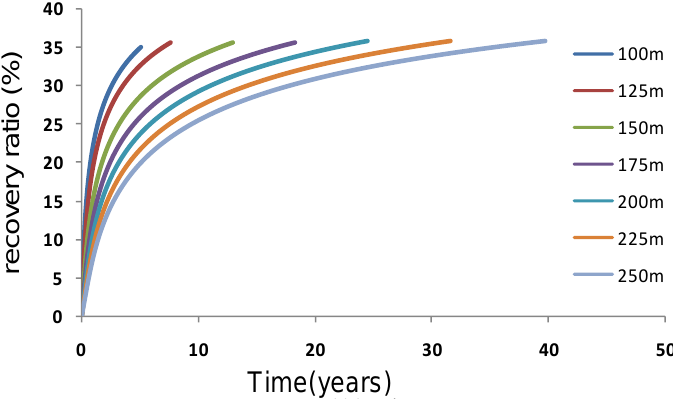
Figure 2—Relation curve between recovery ratio and time with different well spacing.